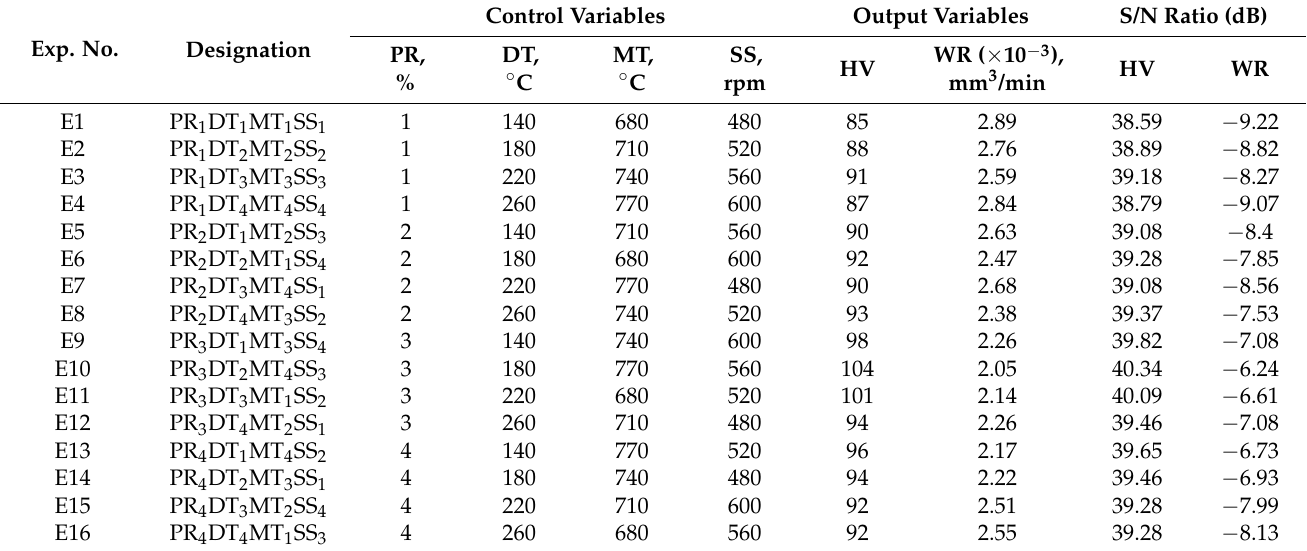
Table 2. Stir casting L 16 experimental data.